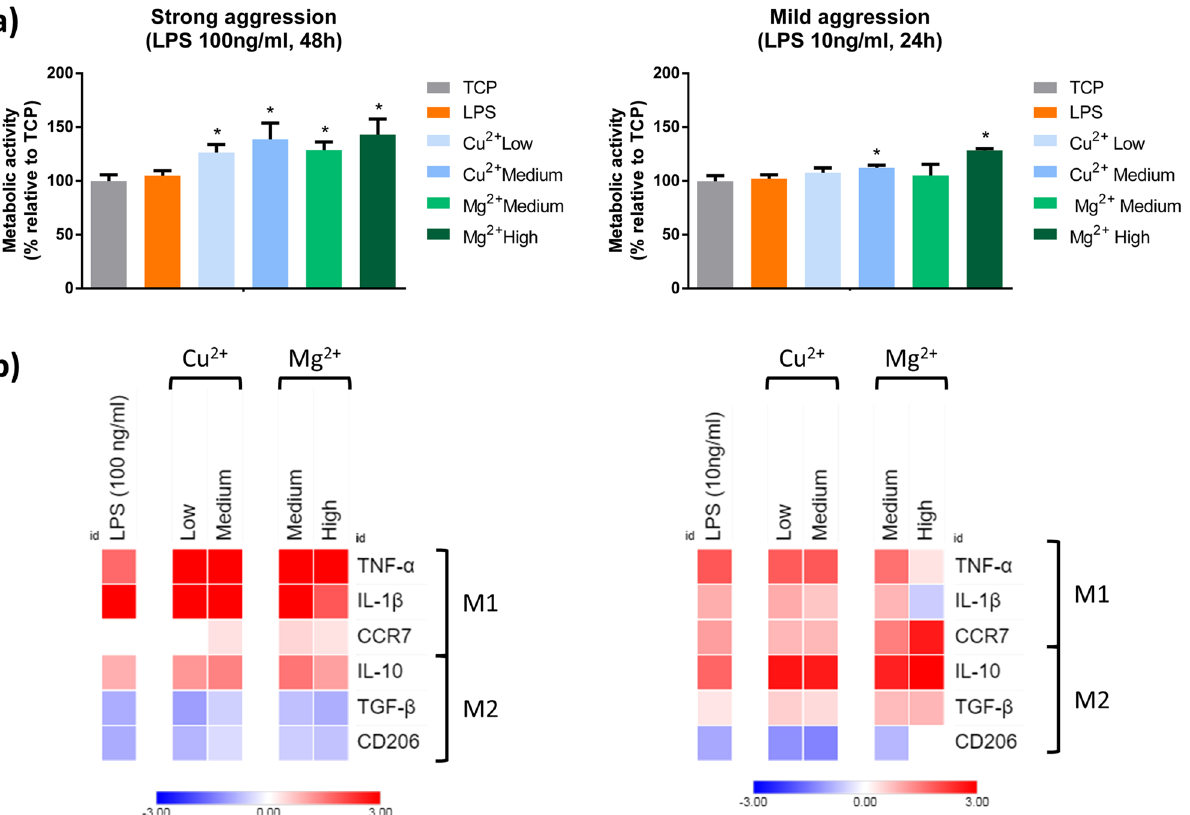
Figure 6. Effect of the combination of LPS with Cu 2+ and Mg 2+ on THP-1 cell metabolic activity ( a ) and gene expression of M1 and M2 markers ( b ). THP-1 cells were stimulated with a combination of Cu 2+ and Mg 2+ and 100 ng/ml LPS for 48 h (strong pro-inflammatory stimulation) or 10 ng/ml LPS for 24 h (mild pro-inflammatory stimulation). ( a ) Metabolic activity results were represented as percentage relative to an unstimulated control (TCP) and compared with the TCP of each day. Statistical significance was accepted at p < 0.05 and represented with *. ( b ) M1 markers (TNF-α, IL-1β and CCR7) and M2 markers (IL-10, TGF-β and CD206) were determined by RT-qPCR. Results were normalized against β-actin mRNA and are expressed relative to the mRNA levels of unstimulated THP-1 macrophages. Statistical analysis is in Supplementary Tables S4, S5, S6 and